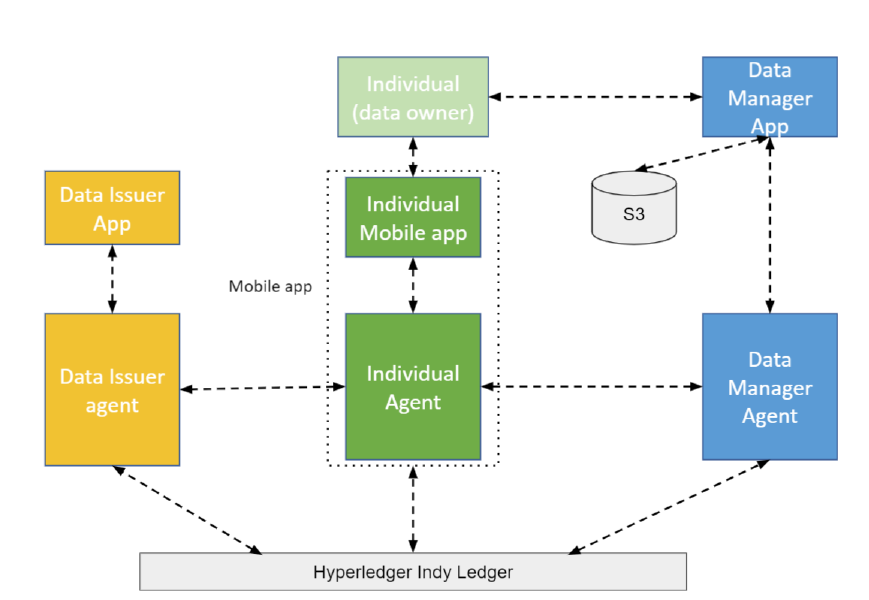
Fig. 7. Data issuing and storage